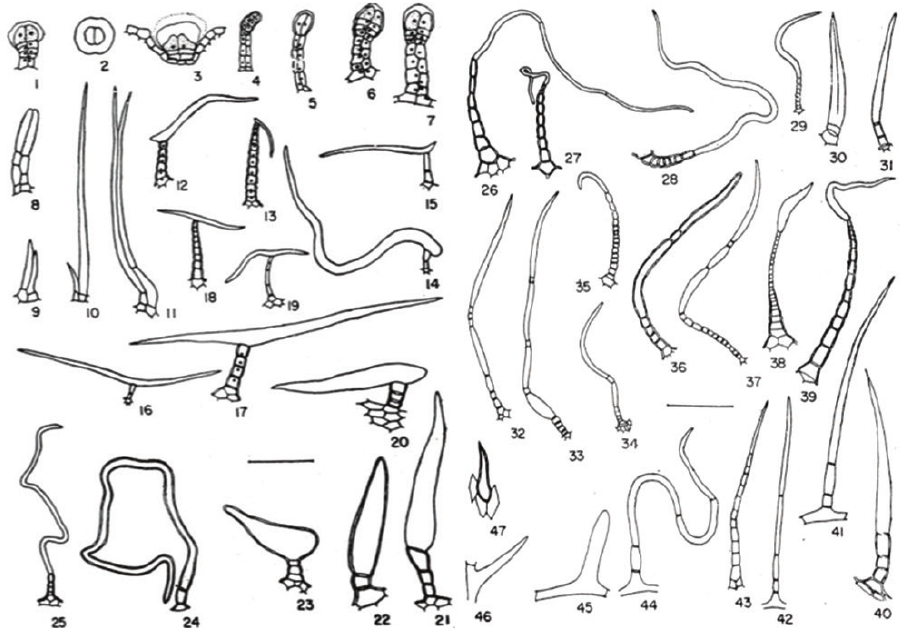
Figure 2. Vernonieae trichome types used in morphological descriptions and UPGMA analysis. 1– 7 Glandular 8–1 . Biseriate or twin 12–15 One armed 16–19 T-shaped 20–23 Swollen terminal celled 24–25 Flagellate 26–28 Whip-shaped 29–31 and 45 Cylindrical 32–44 Filiform 46–47 Prickly (Ap- plied from Narayana